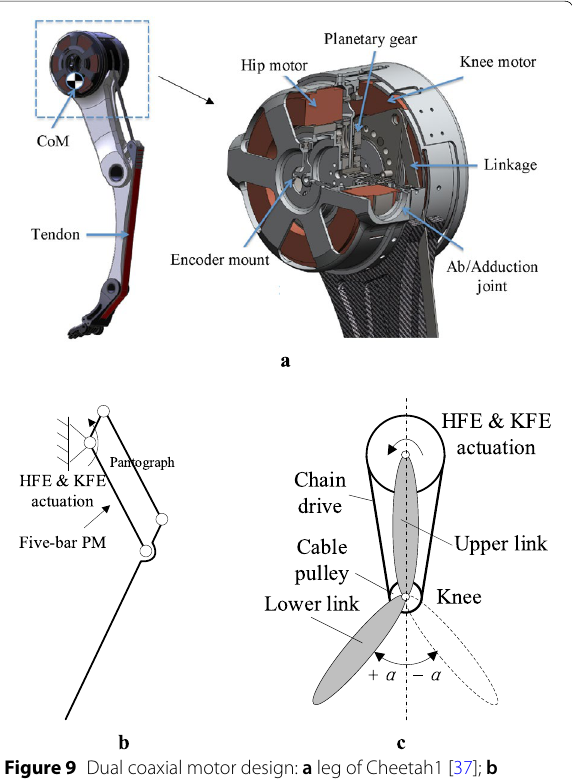
Figure 9 Dual coaxial motor design: a leg of Cheetah1 [37]; b five-bar PKM; c chain